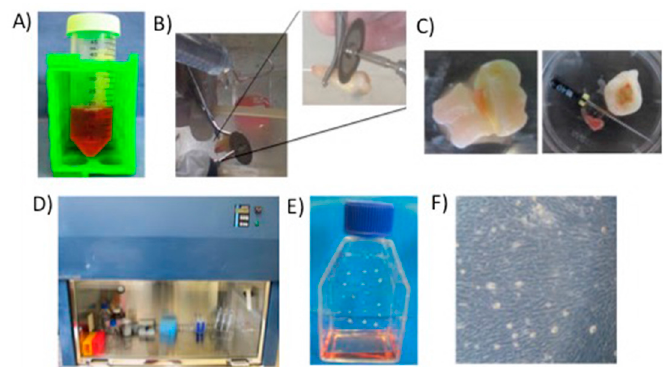
Figure 1. Procedure for culture and proliferation of dental pulp stem cells (DPSCs) used in bone tissue engineering as reported in Martin-del-Campo et al. ( A ) Dental organs stored in culture medium and antibiotics. ( B ) Segmentation of dental organs. ( C ) Extraction of dental pulp. ( D ) Laminar flow hood for cellular handling. ( E ) Generated cellular nodules from cells. ( F ) Expanded Dental Pulp Mesenchymal Stem Cells [16].